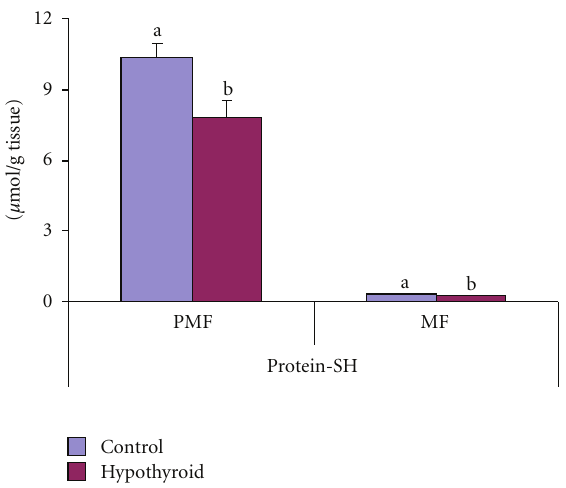
Figure 4: E ff ect of neonatal PTU treatment on protein-SH content ( µ mol/g tissue) in postmitochondrial fraction (PMF) and mito- chondrial fraction (MF) of testes of rats. Data are expressed as mean ± S.D. of 5 observations and subjected to unpaired Student’s t -test. Statistical significance was accepted at P < 0 . 05. Control and hypothyroid groups were found to di ff er significantly at P < 0 . 05 as represented by superscripts of di ff erent letters. Control (Group-I): 30-day-old control rats; hypothyroid (Group-II): 30- day-old rats with PTU treatment from day 1 postpartum to day 30 postpartum.